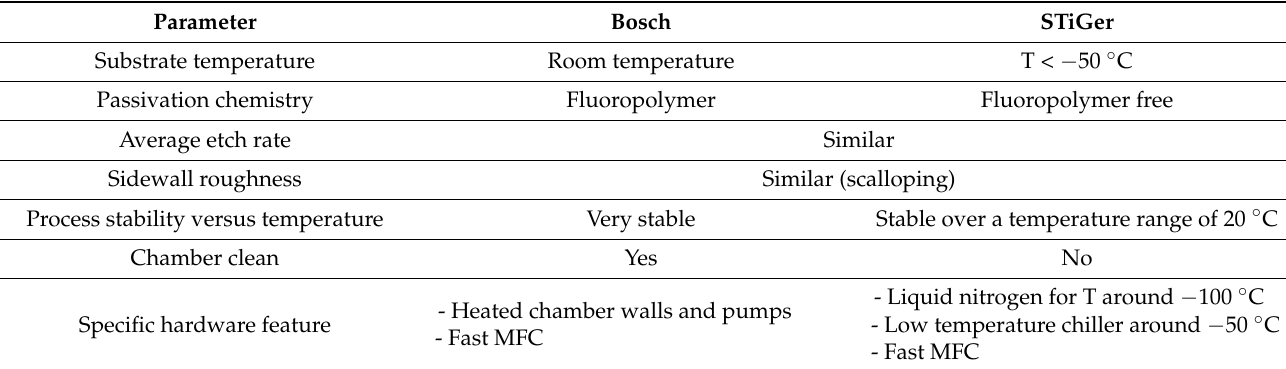
Table 3. Summary of the comparison between Bosch and STiGer